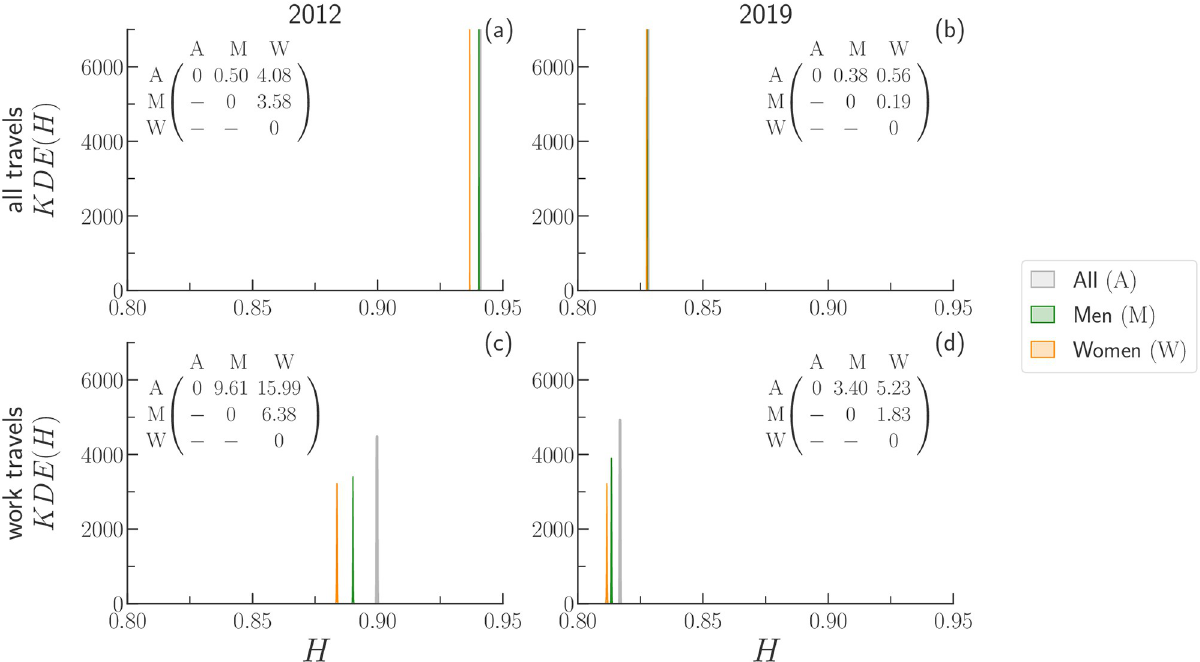
Fig 4. Kernel Density Estimation plots of the mobility diversity, H , for all travels (panels a and b) and work travels (panels c and d) in the urban area of BGT . For each travel purpose, we plot KDE( H ) for travels made by men ( M ), women ( W ), and all travellers ( A ). The matrix appearing within each graphic summarises the distances between the medians of the distributions (peak-to-peak distances multiplied by 10 − 3 ).